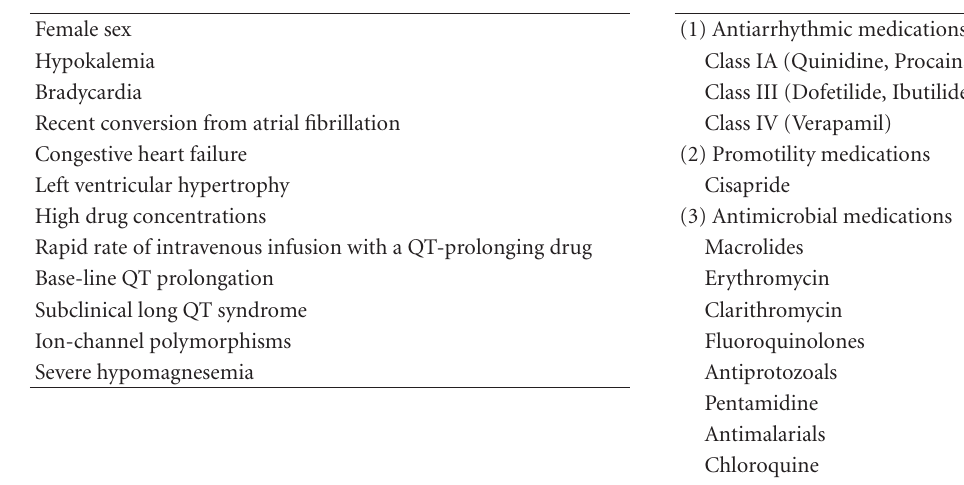
Table 1: Risk factors for drug-induced torsade de pointes. Table 2: Drugs implicated in torsades de